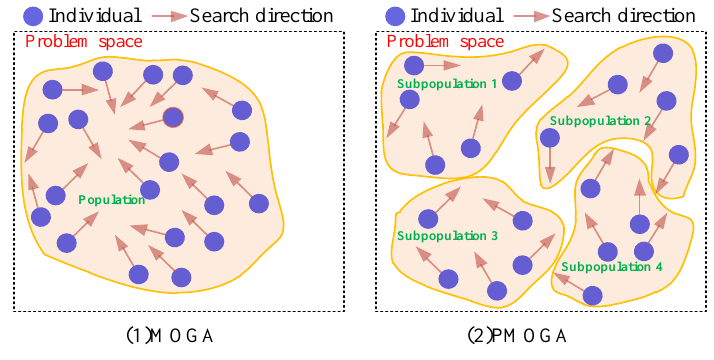
Figure 4. Maps of the evolution process of ( 1 ) MOGA and ( 2 ) PMOGA.